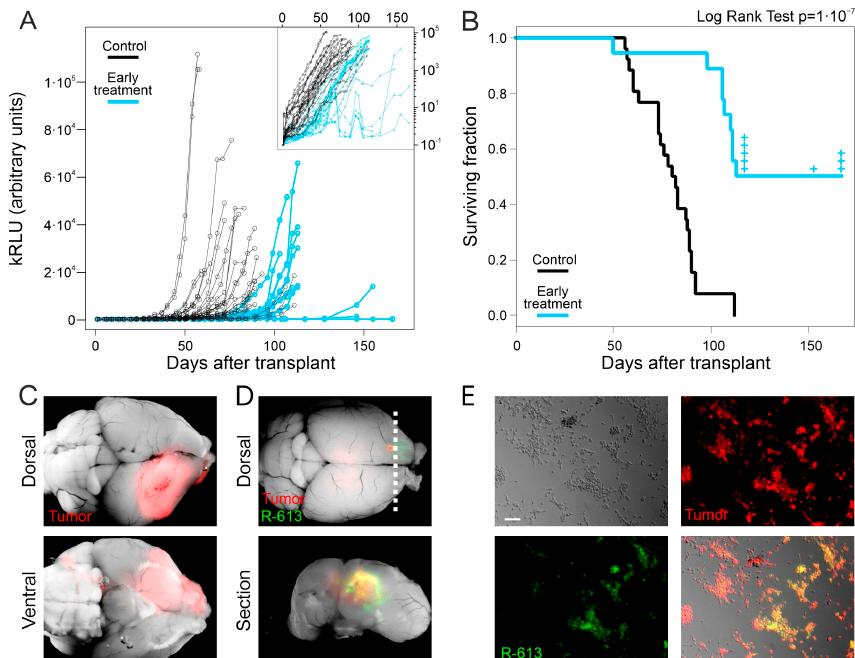
Figure 2. Early treatment with oHSV R-613 on L0306 human glioma cells. ( A ) Levels of Gluc in blood samples over time in mice transplanted with L0306 human glioma cells infected (blue) or not infected (black) with R-613. Each point represents the moving average of the values with a sliding window of 10 days, centered on the indicated time. In the inset, the same curves are in logarithmic scale. ( B ) Kaplan–Meyer survival curves of mice transplanted with L0306 human glioma cells infected (blue line, early treatment) or mock infected (black line, control) with R-613. ( C ) Representative merged fluorescence and brightfield images (dorsal and ventral view) of a mouse brain from the control arm. ( D ) Representative merged fluorescence and brightfield image of a mouse brain from the early treatment arm and corresponding coronal section at the indicated position (dashed line). ( E ) Fluorescence and bright-field microphotographs of murine glioma cells expressing EGFRvIII infected with the filtered supernatant of an in vitro culture of a glioma explanted from the early treatment arm. Scale bars: 25 µm.